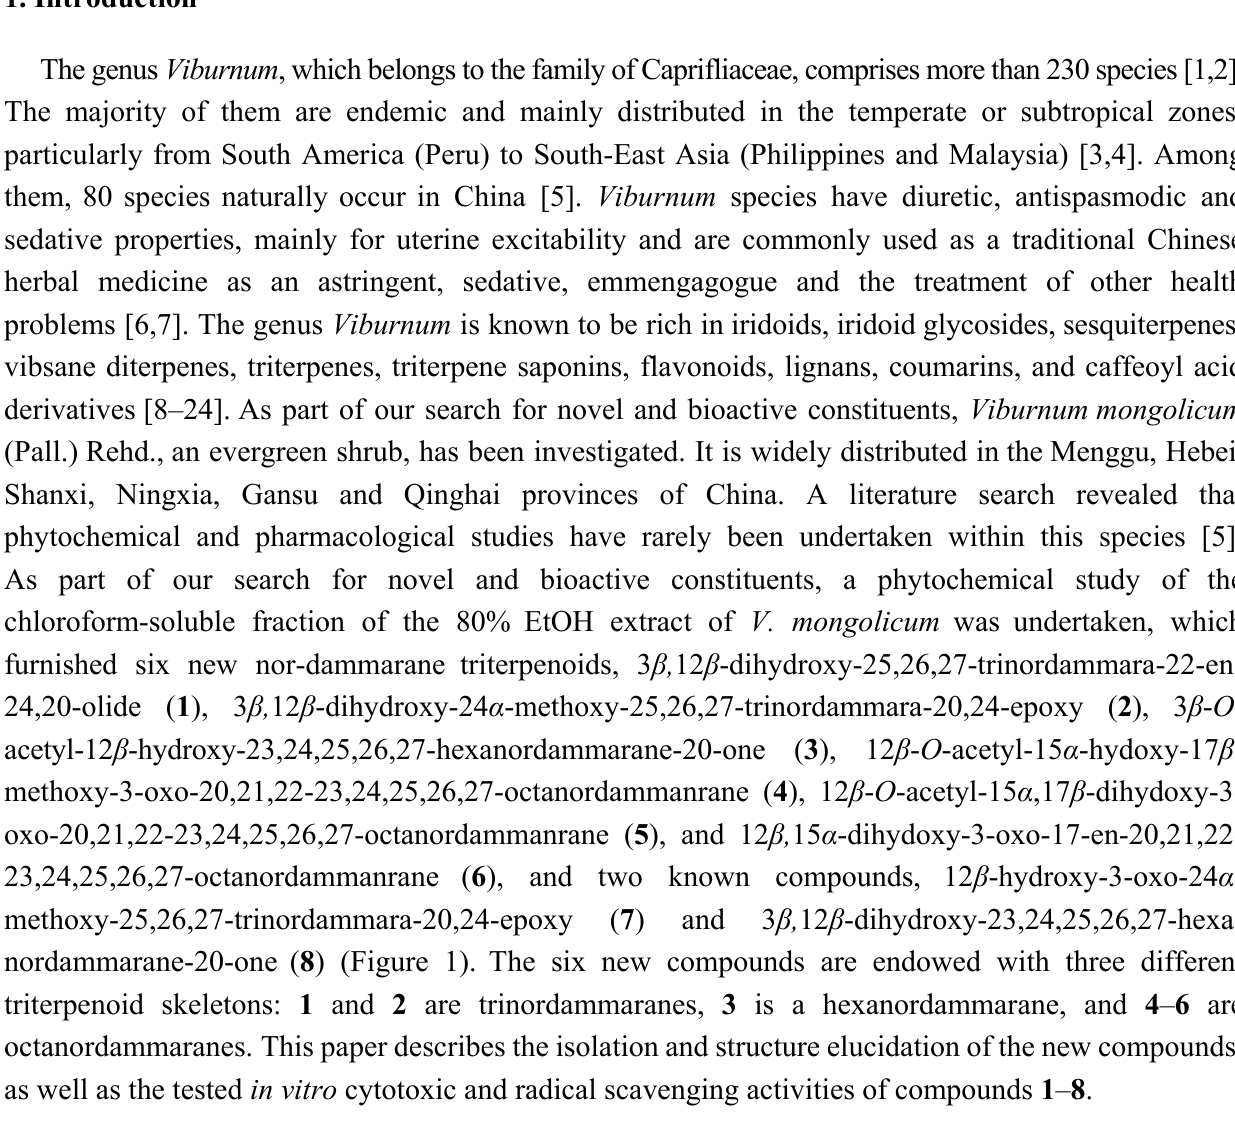
Figure 1. Structures of compounds 1 – 8